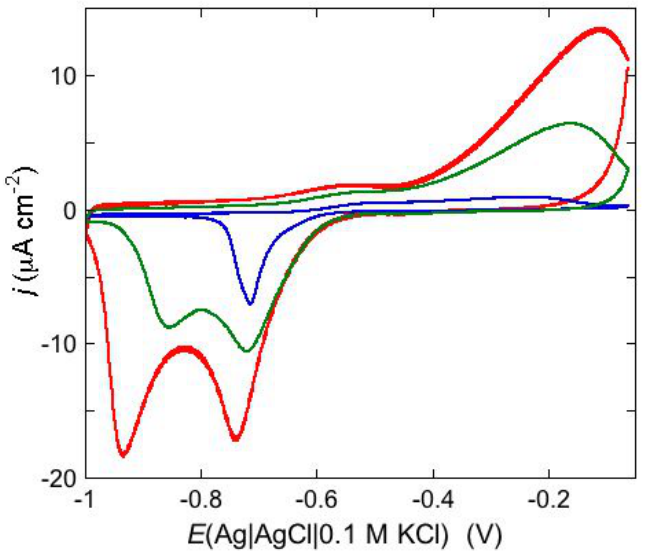
Figure 13. Cyclic voltammograms of a DPTL/DOPC tBLM stabilized in aqueous 0.1 M KCl containing 1 μ M TCG. In the order of increasing height, the scan rates are 10, 100 and 200 mV s − 1 .